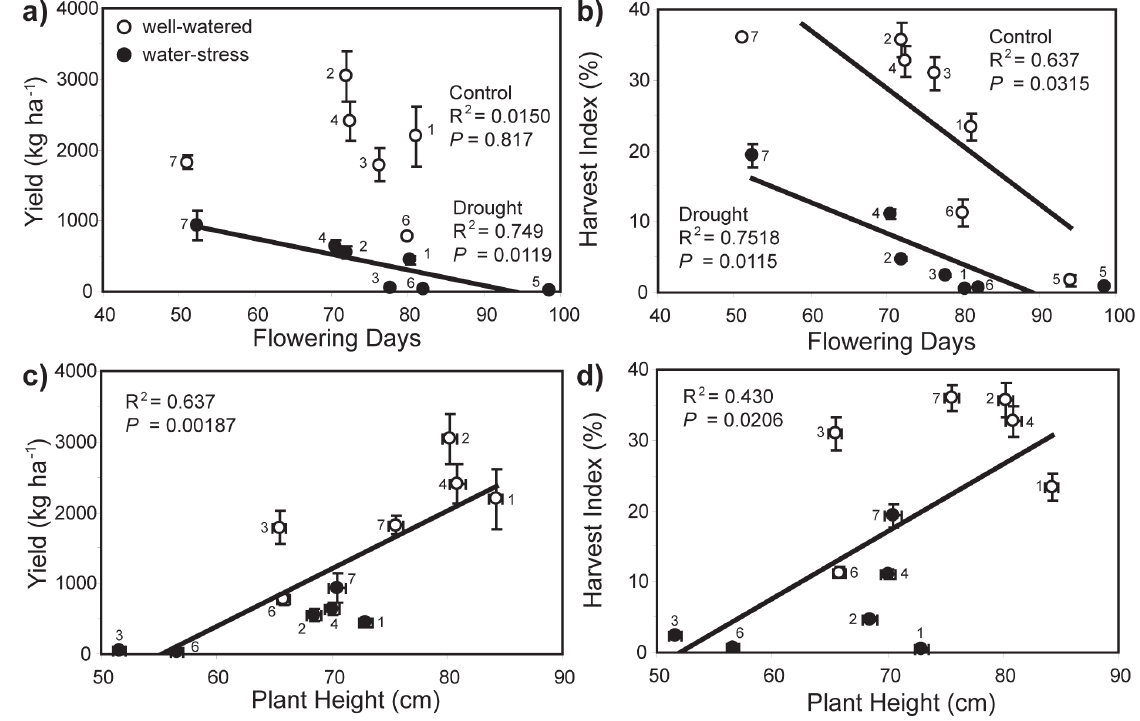
Figure 1. The performance of seven rice varieties under well-watered (open symbols) and drought conditions (closed symbols): a) relationship between yield and flowering days (period of time for 50% of plants to develop flowers) under full-water (linear regression: R 2 =0.0150; F 1,4 =0.0609; P =0.817) and drought (linear regression: R 2 =0.749; F 1,5 =14.905; P =0.0119); b) allometric relationship between yield and plant height (linear regression: R 2 =0.637; F 1,10 =17.536; P =0.00187); c) relationship between harvest index ( HI :dry weight of grain relative to dry total plant biomass) and flowering days under full-water (linear regression: R 2 =0.637; F 1,5 =8.760; P =0.0315) and drought (linear regression: R 2 =0.752; F 1,5 =15.144; P =0.0115), and; d) relationship between HI and plant height (linear regression: R 2 =0.430; F 1,10 =7.548; P =0.0206). Error bars indicate one standard error either side of the mean. Numbers next to data points indicate Oryza sativa variety: 1=Apo; 2=IR55; 3=IR64; 4=IR71; 5=Moro; 6=PSBRc80;